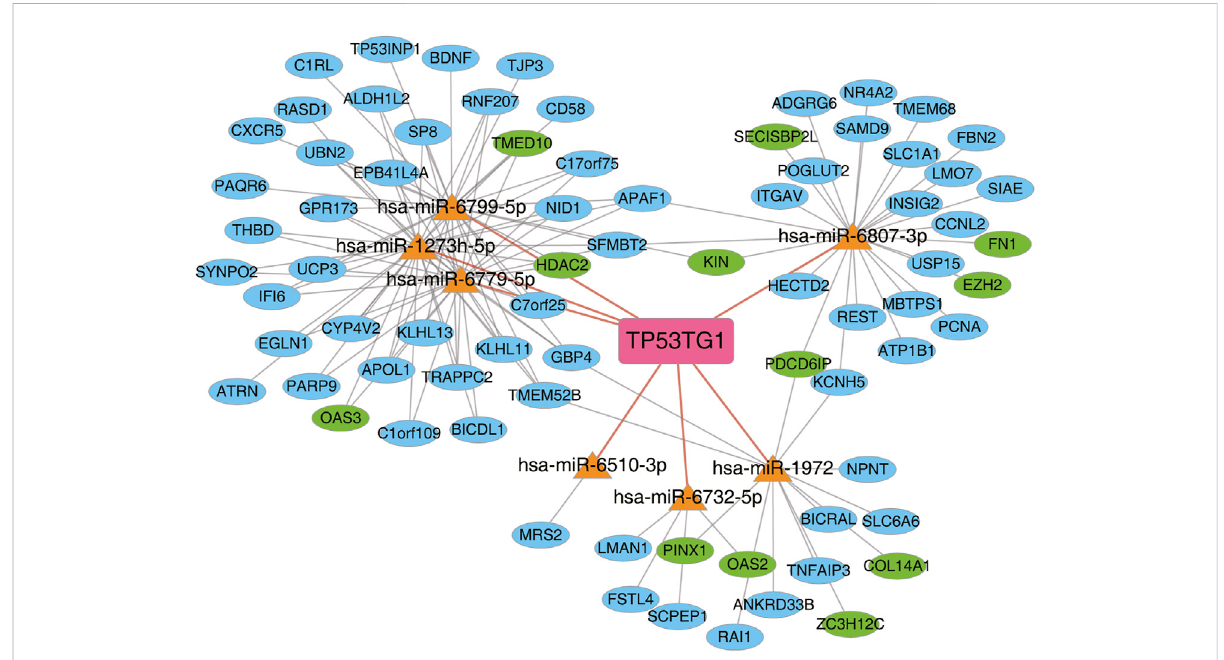
FIGURE 6 The regulatory network of lncRNA-miRNA-DEG mediated by TP53TG1 was deregulated in HeLa cells. TP53TG1-mediated ceRNA network. Miranda and Rnahybrid were used to predict the target relationship between miRNA and TP53TG1. miRNA-mRNA target pairs from miRDB (http:// mirdb.org) and targetscan (http://www.targetscan.org) databases were used to predict the target relationship between miRNA and TP53TG1- regulated